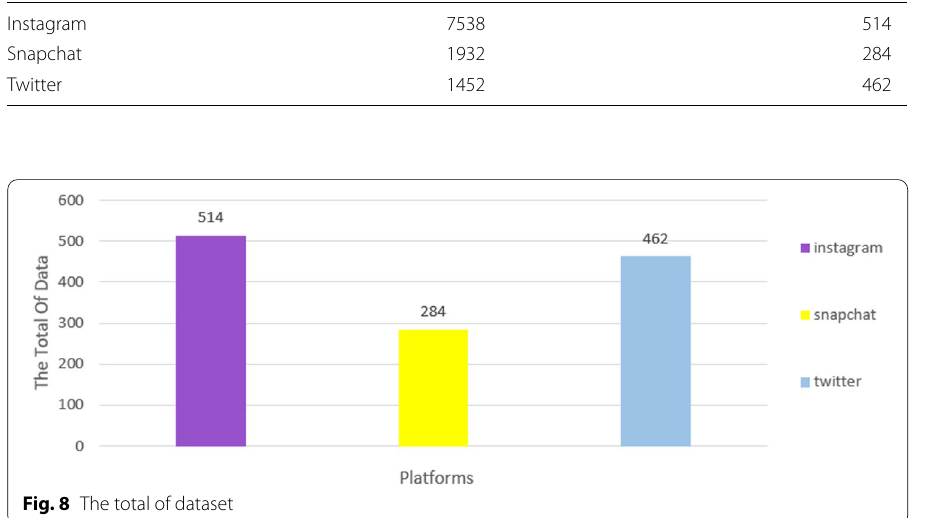
Table 3 Number of datasets before and after pre-processing stage